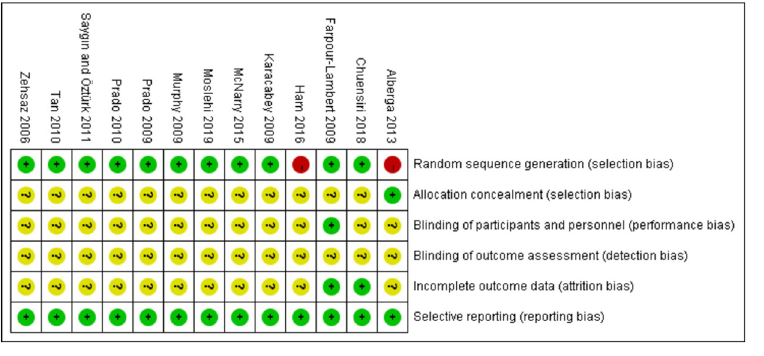
Fig 2. Risk of bias